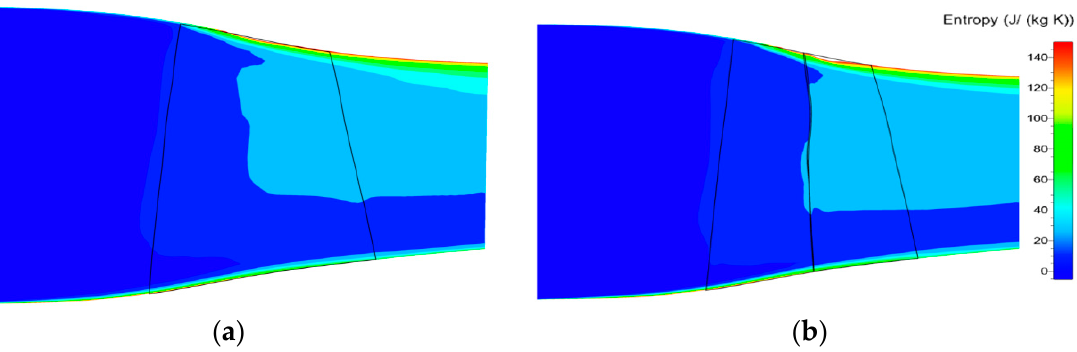
Figure 5. The meridian view and entropy distribution of rotor37 and the original tandem rotor. ( a ) the rotor37. ( b ) the tandem rotor.